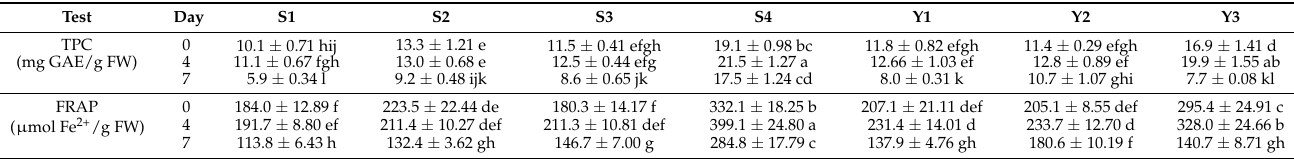
Table 8. TPC and FRAP of the studied